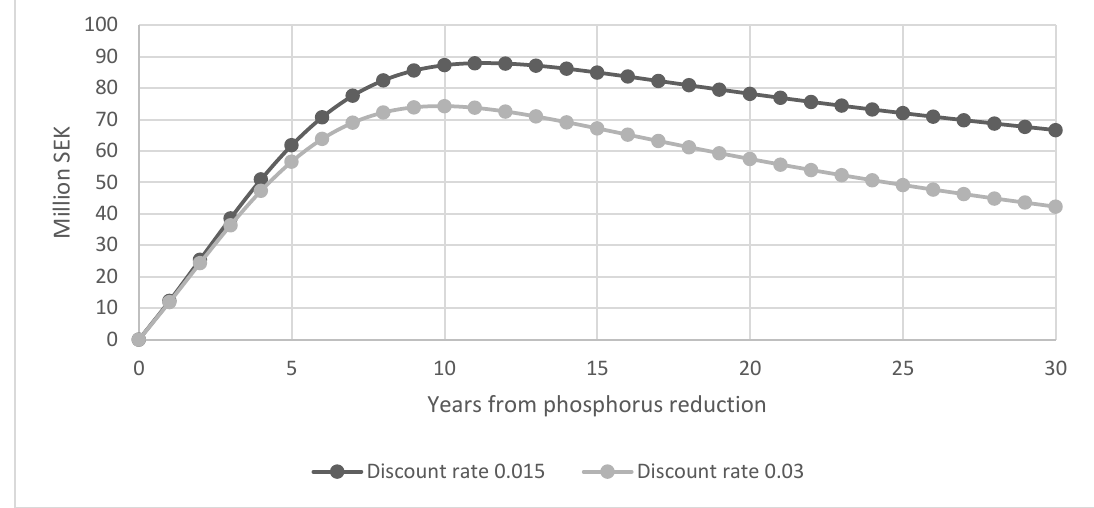
Fig. 4. Predicted annual value (million SEK) of the increase in the perch population off the east coast of Sweden over time following a 40% reduction in phosphorus loads to the Baltic Proper, calculated using two different discount rates (0.015 and